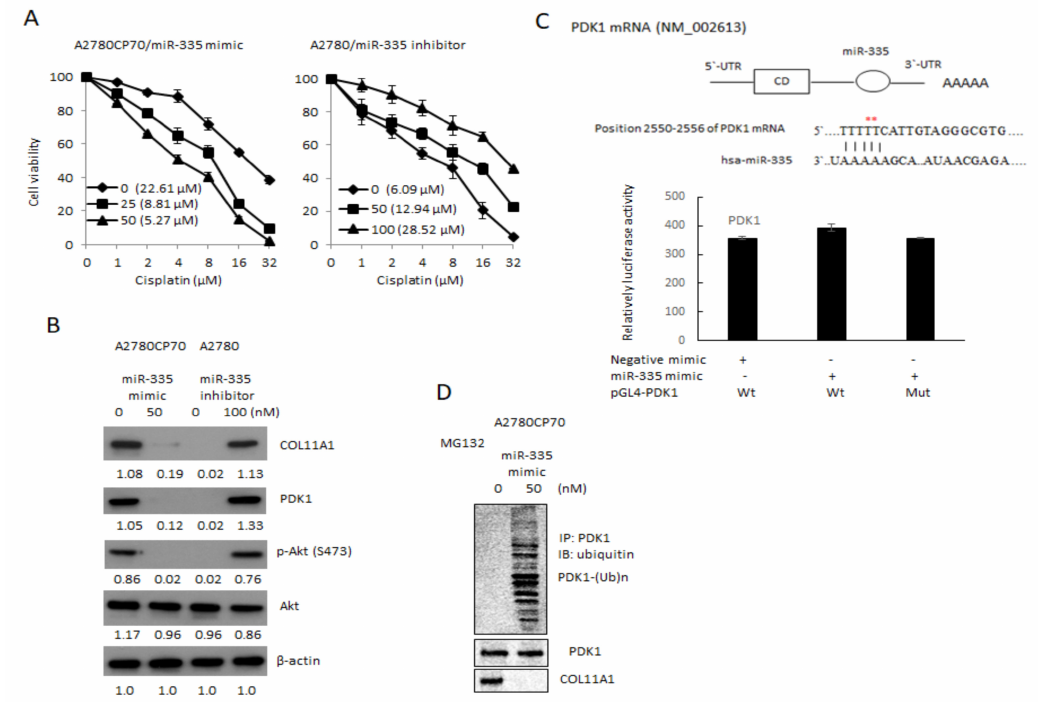
Figure 3. Drug sensitivity of epithelial ovarian carcinoma cells is regulated by miR-335. ( A ) A2780CP70 cells transfected with miR-335 mimic and A2780 cells transfected with miR-335 inhibitor for 48 h, subsequently treated with different concentrations of cisplatin for 48 h. Cell viability was assessed by 4,5-dimethylthiazol-2-yl)-2,5-diphenyltetrazolium bromide assays. All experiments were performed in triplicate. ( B ) The protein expression of collagen type XI alpha 1, PDK1, p-Akt (S473), and Akt in A2780 cells transfected with miR-335 inhibitor, as well as A2780CP70 cells transfected with miR-335 mimic, were evaluated by western blot. β -Actin is used as a protein loading control (Figure S2B). ( C ) Upper panel: the putative miR-335 binding site in its 3 (cid:48) UTR contains mutant wt-PDK1 and corresponding mut-PDK1 (red star). Lower panel: wt-PDK1/mut-PDK1 vector and miR-335 NC/miR-335 mimic were co-transfected into A2780CP70 cells. Compared with the control group, miR-335 mimic transfection did not significantly decrease the luciferase activity of the wt-PDK1 reporter gene. In co-transfected cells with miR-335 and mut-PDK1 reporter genes, there was no significant decrease in reporter gene activity. ( D ) A2780CP70 cells transfected with miR-335 mimic were treated with MG132 for 6 h, and the cell lysates were immunoprecipitated with anti-PDK1 antibodies. The resulting IPs were analyzed by IB, using an anti-ubiquitin antibody (Figure